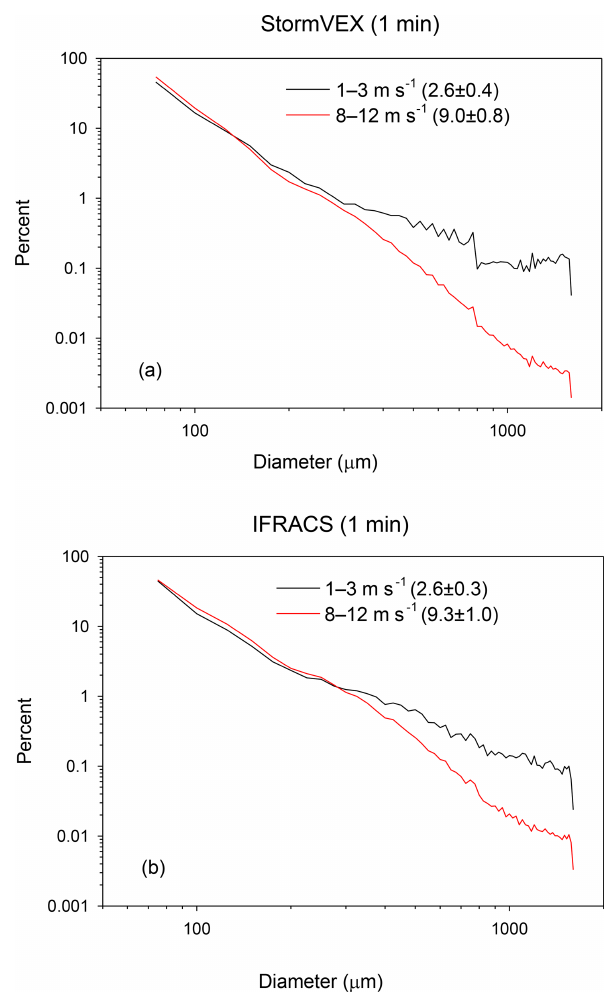
Figure 12. Averages of 1min relative (% of N i ) CIP PSDs at low (1–3ms − 1 ) and high (8–12ms − 1 ) TAS during StormVEx (a) and IFRACS (b) . Average TAS values are shown in